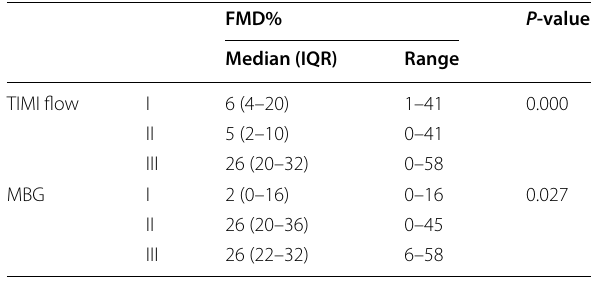
Table 3 Relation between FMD% and the TIMI flow, the MBG